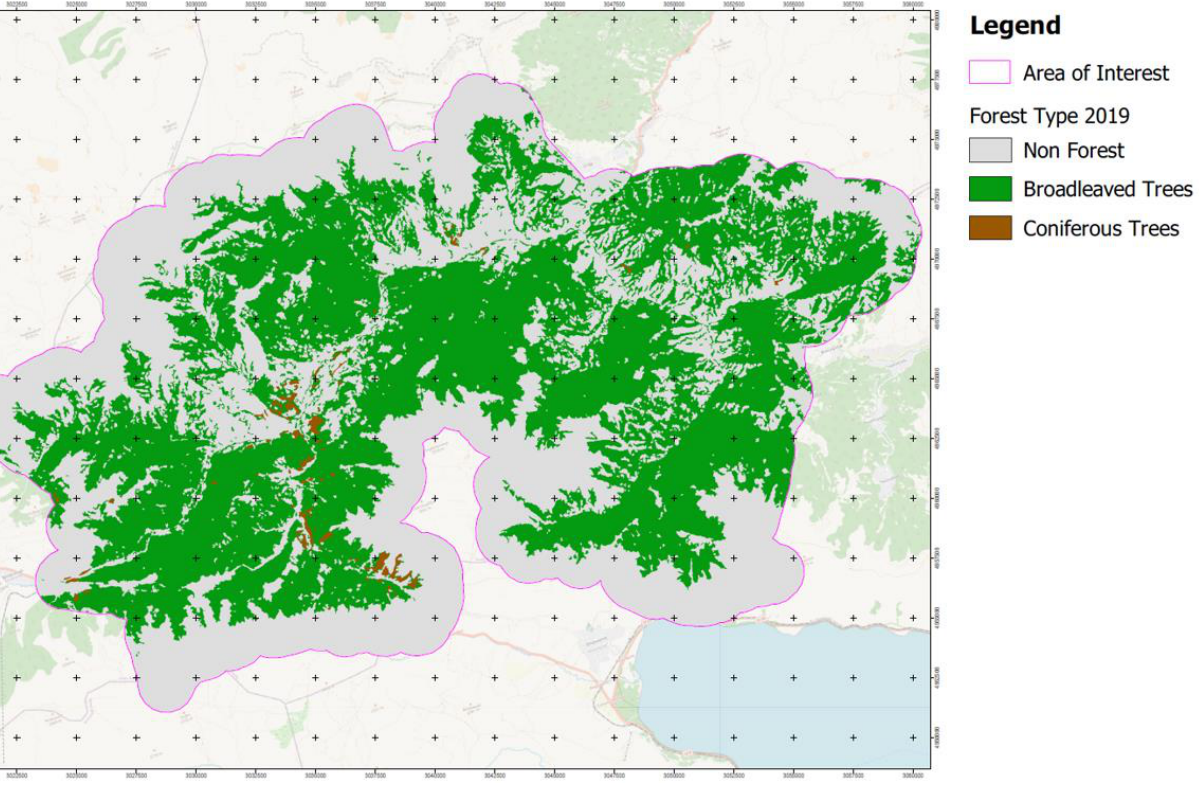
Table 4. Forest perturbation on Dilijan National Park over the 1991–2019 period.